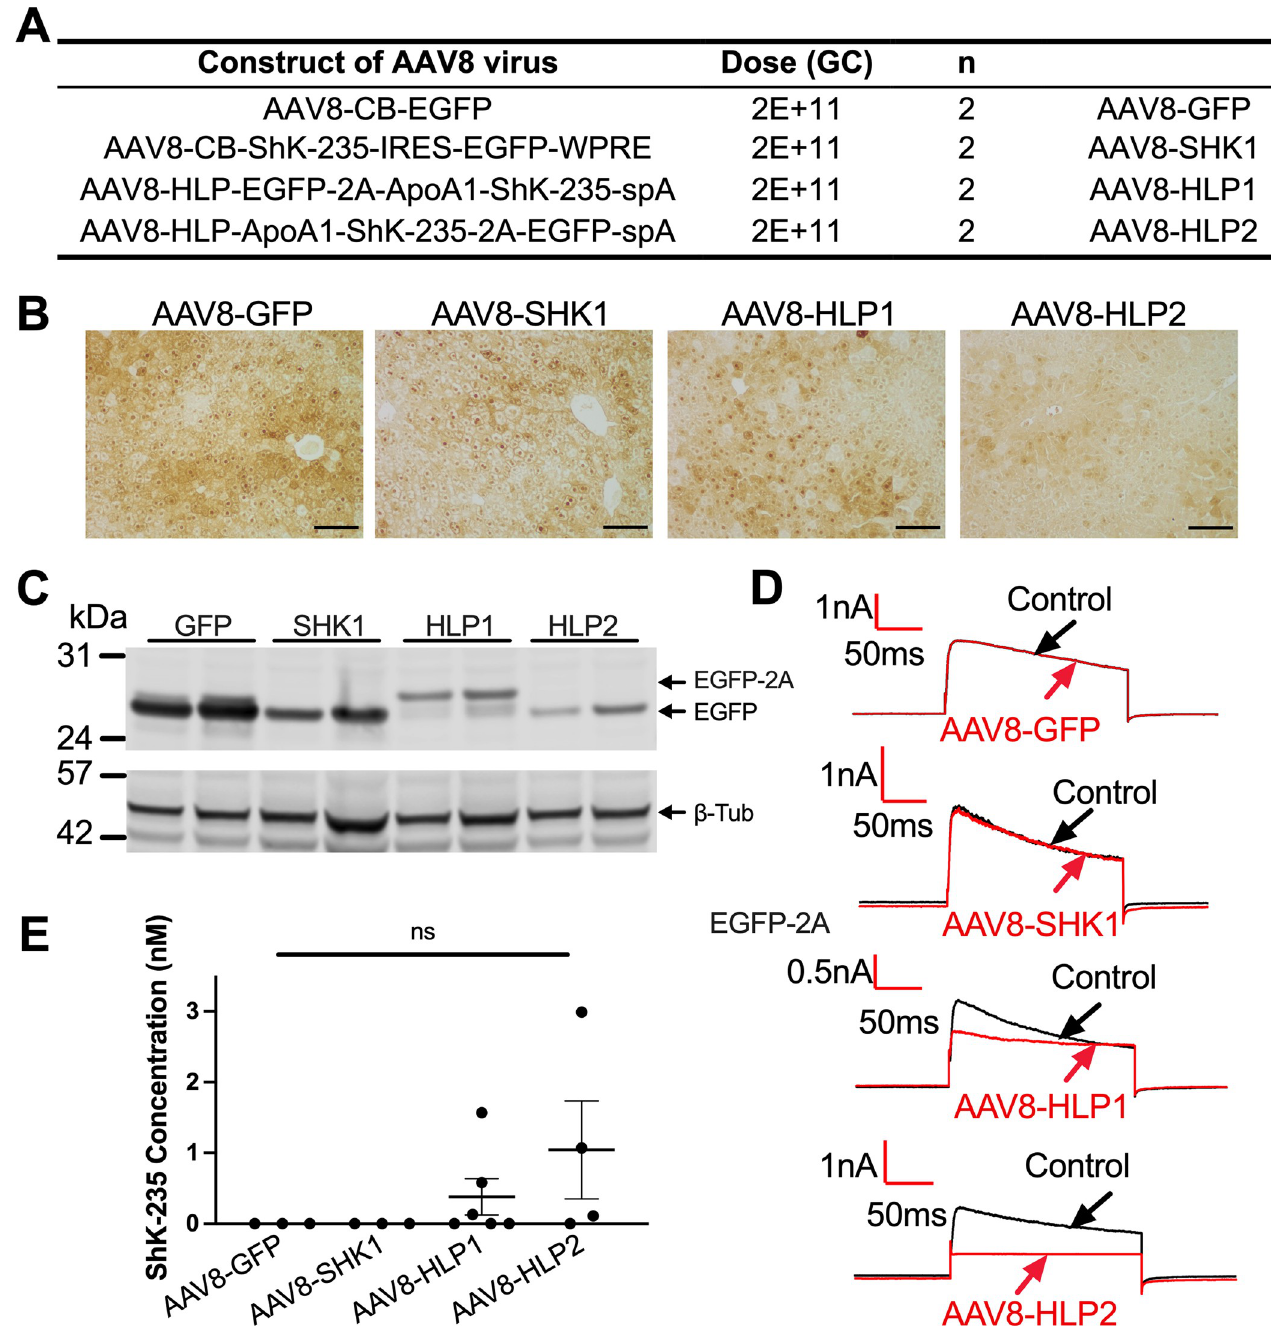
Fig 2. Efficient and specific GFP and ShK-235 peptide expression in mice liver following AAV8-based delivery. (A) AAV8 constructs and doses injected intraperitoneally into male mice. GC = genome copies. N = 8, or 2 male mice per group. (B) Representative IHC images of mouse livers showing EGFP expression. Scale bars = 100 μ m. (C) Western blot analysis of EGFP in liver lysates from mice injected with AAV8 constructs in (A) , with β -tubulin ( β -Tub) used as a loading control. (D) Representative whole-cell Kv1.3 currents in L929 fibroblasts stably expressing mKv1.3 before (control) and after application of serum from mice injected with AAV8-GFP, AAV8-SHK1, AAV8-HLP1, or AAV8-HLP2, diluted 1:50. Serum was collected 2 weeks post vector delivery. (E) ShK-235 concentration in serum of mice injected with AAV8-GFP, AAV8-SHK1, AAV8-HLP1, or AAV8-HLP2. Each serum sample was tested on 3 cells each.